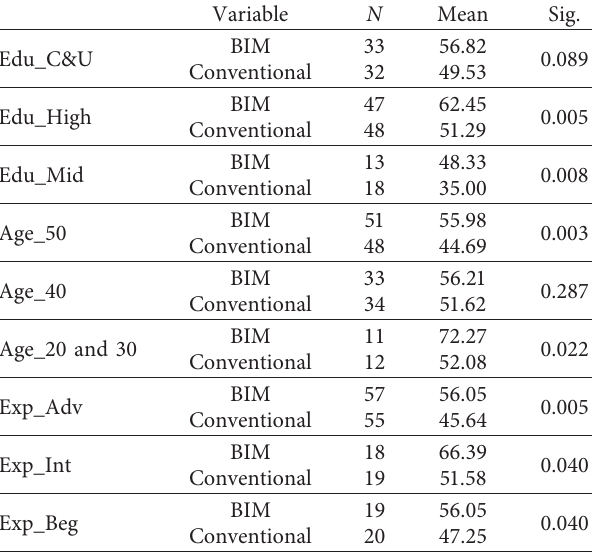
Table 4: t -test result by workers’ factor group. Table 5: Questionnaire survey data to examine the experimental